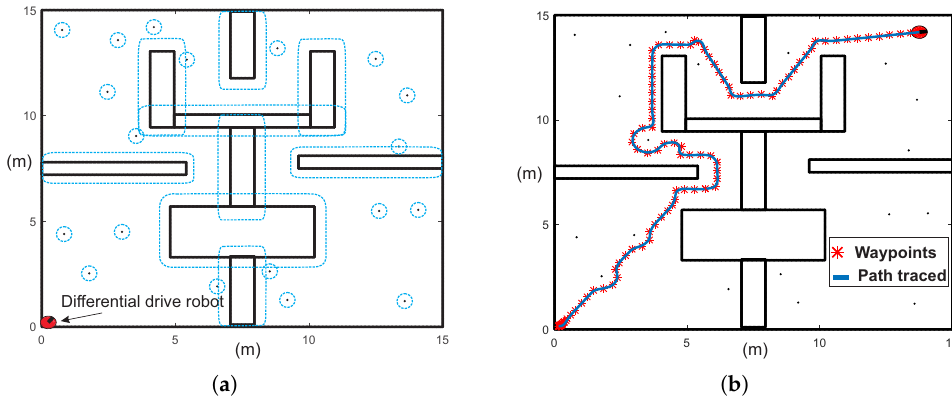
Figure 28. Pure-pursuit path tracking for the solution path of case study 3. ( a ) Floor plan considering dimensions of robot. ( b ) Path traced by differential drive robot.